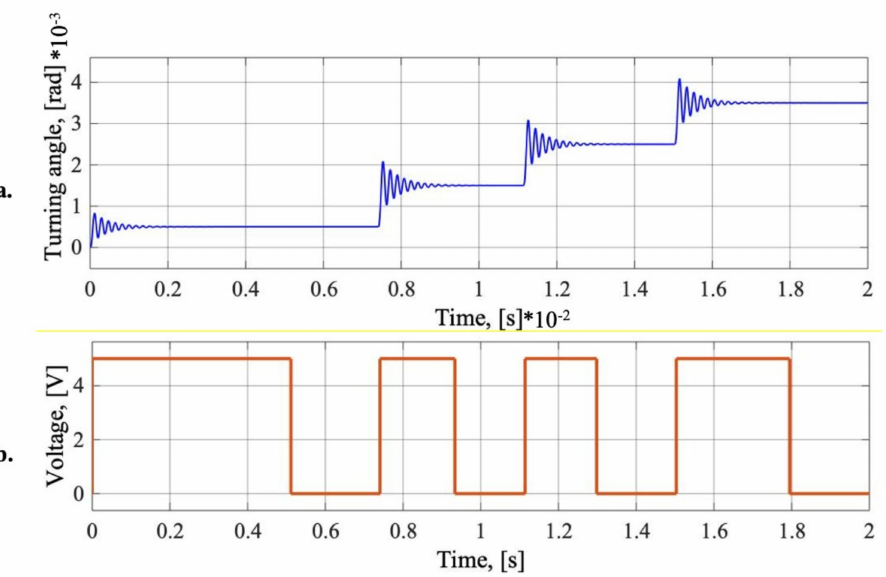
Figure 9. Time charts, ( a ) transient process of the rotation angle of a stepper motor shaft, ( b ) transient process of the control action on stepper motor controllers.